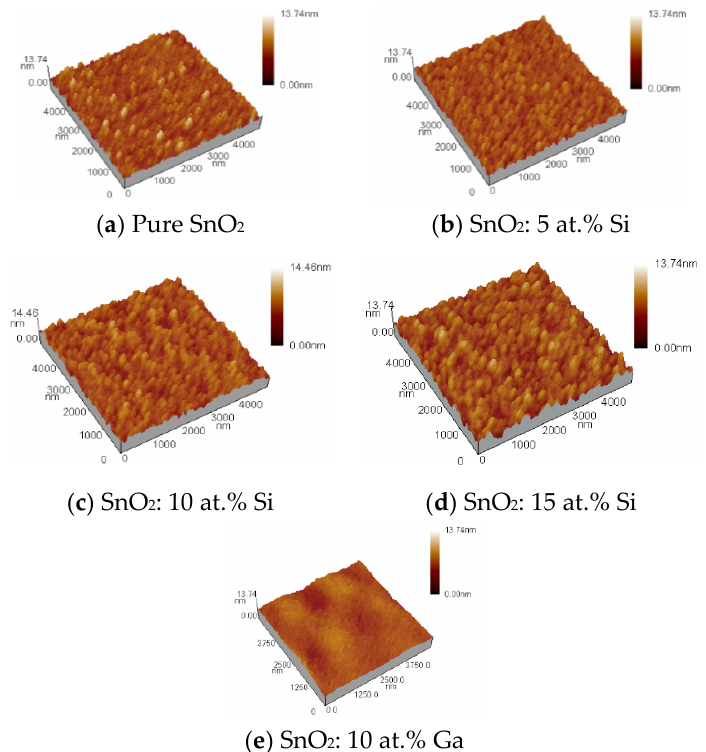
Figure 2. The AFM images of SnO 2 :Si films and SnO 2 :Ga film: ( a ) Sq = 1.32, ( b ) Sq = 0.74, ( c ) Sq = 0.93, ( d ) Sq = 1.08, ( e ) Sq = 0.93.